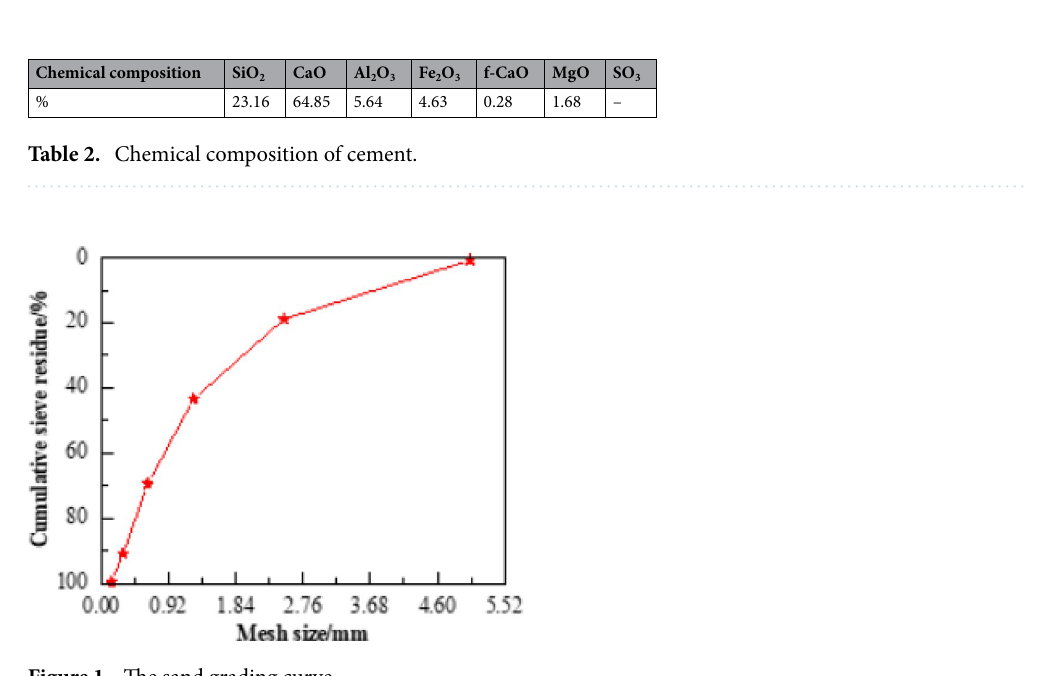
Figure 1. The sand grading